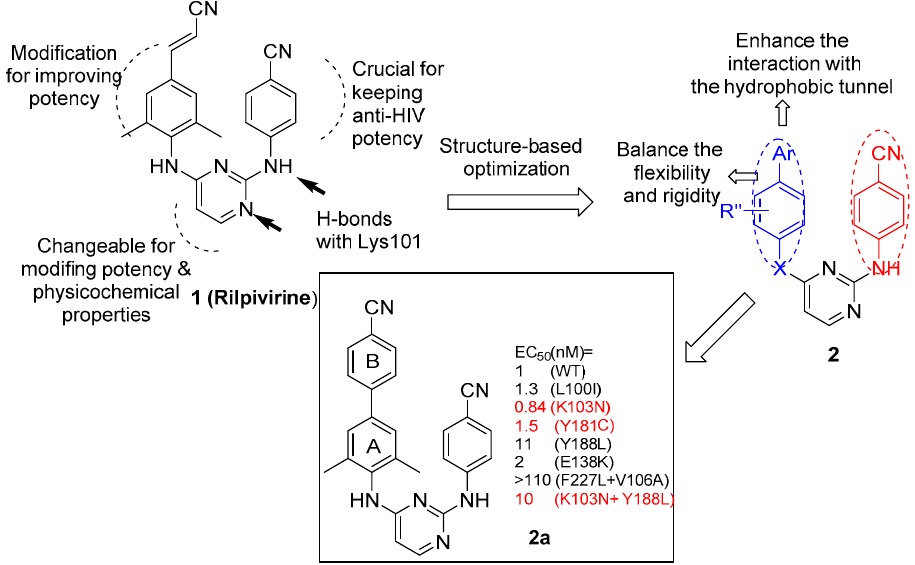
Figure 1. Design of new DAPY-NNRTIs based on the biphenyl-substituted pyrimidine